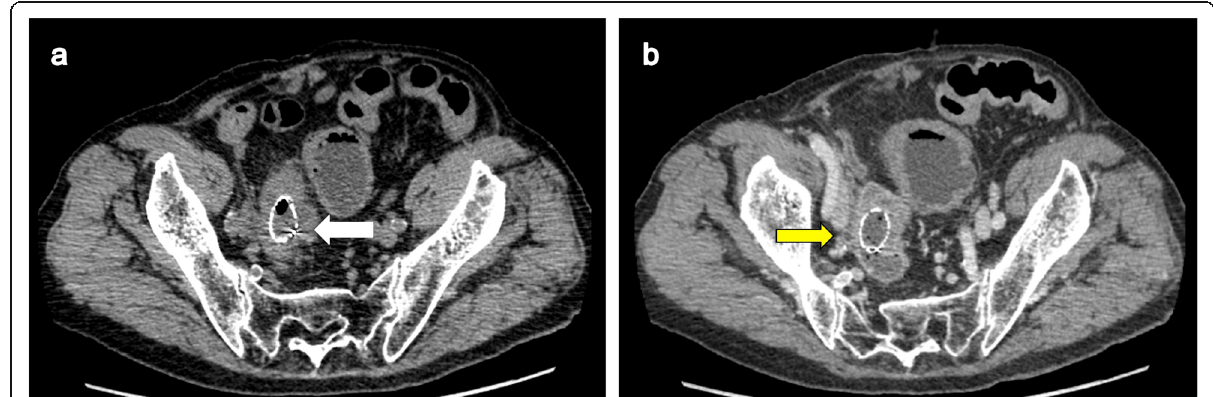
Fig. 3 a Abdominal multi-detector computed tomography (CT) scan showing decompression of distended bowel and patency of self-expanding